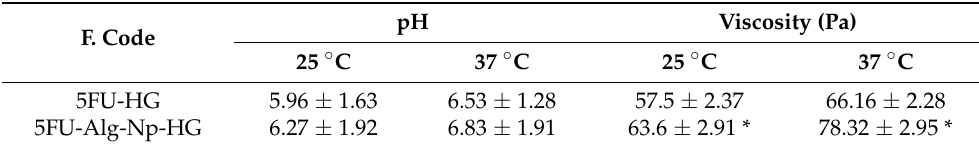
Table 2. Physicochemical properties of the nanoemulsion. F.